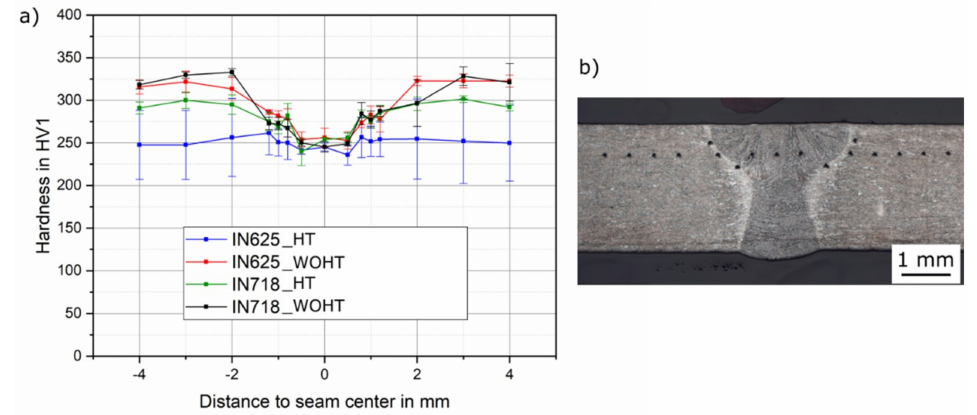
Figure 14. ( a ) Hardness measurements of SLM-manufactured tubes of IN625 and IN718, and ( b ) hardness of laser-welded IN718_HT_SLME as an